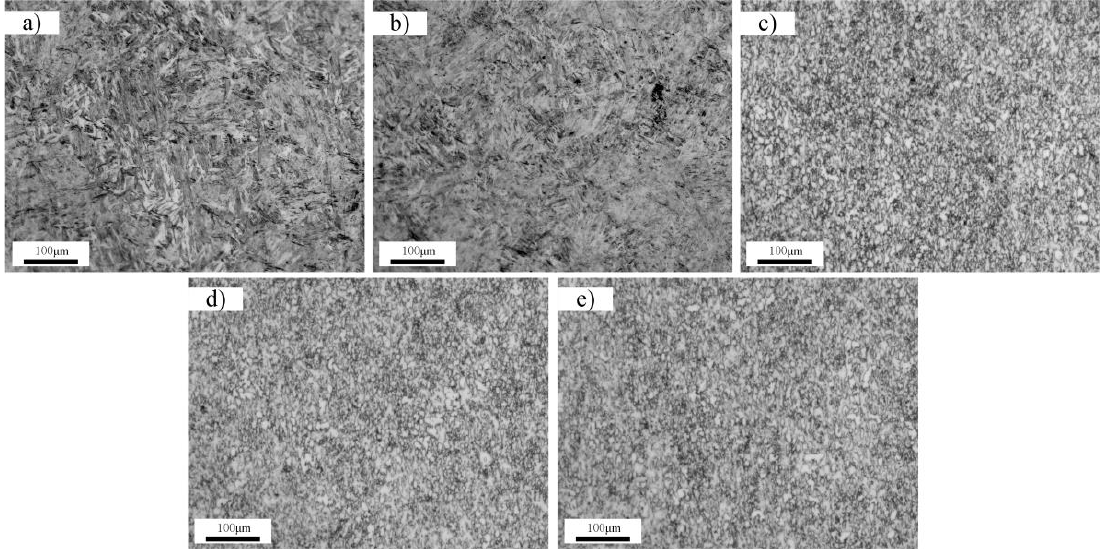
Figure 7. Microstructure of each sample after etching. ( a ) Microstructure of sample A; ( b ) microstructure of sample B; ( c ) microstructure of sample C; ( d ) microstructure of sample D; ( e ) microstructure of sample E.